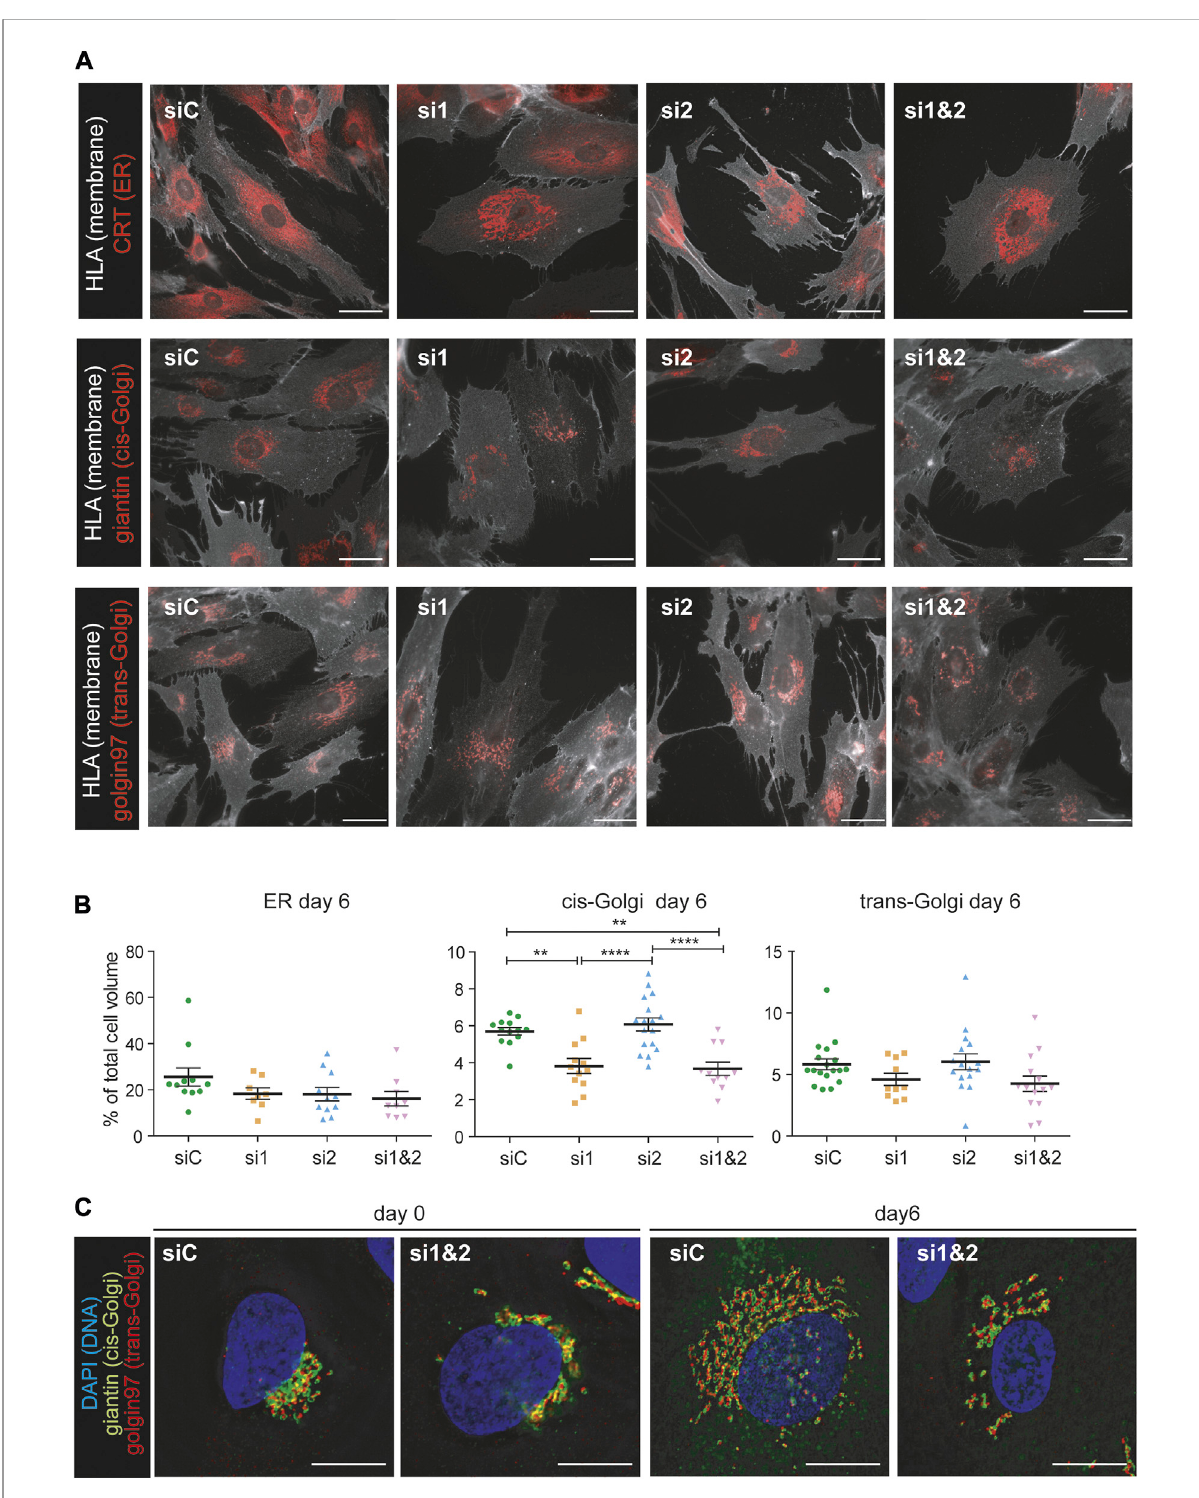
FIGURE 6 CREB3L1 and CREB3L2 drive the decidualization induced rearrangement of the Golgi compartment. (A) T-HESC were treated with scramble duplexes (siC), with duplexes speci fi c for CREB3L1 (si1), CREB3L2 (si2) or both (si1&2). The day after treatment (day0) cells were fi xed with PFA or treated with cAMP and progesterone and then collected at day 6 of decidualization. Cells were fi rst decorated with anti-HLA1 antibody to stain the membrane,andthen permeabilizedand stainedwith antibodiesagainst differentcompartmentof theearly secretory pathway (calreticulin CRT